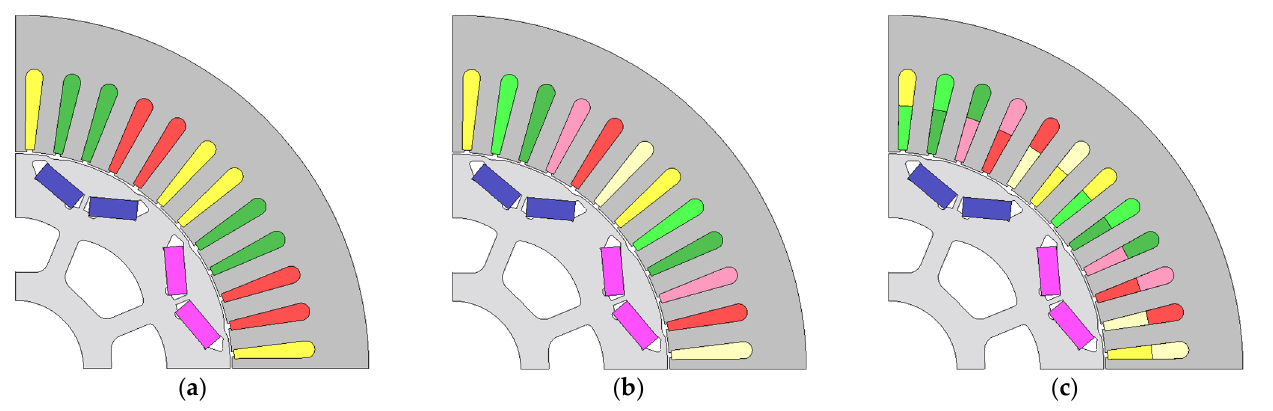
Figure 9. One-fourth models of Prius 2010 machine with different winding configurations: ( a ) ORG; ( b ) DTP-SF; ( c ) DTP-DS. ( b ) DTP-SF; ( c ) DTP-DS.